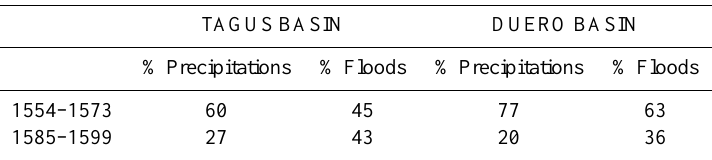
Table 4. Percentages of floods and precipitation by basin and time period.